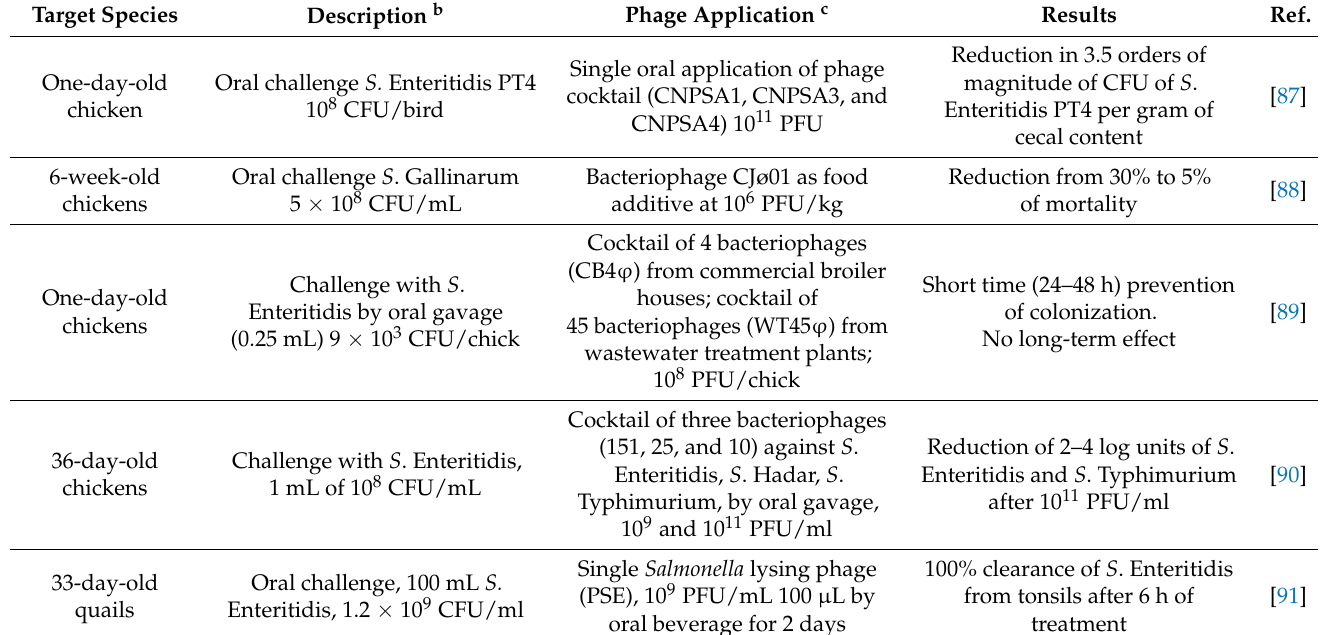
Table 6. Studies on bacteriophage therapy for Salmonella infections in